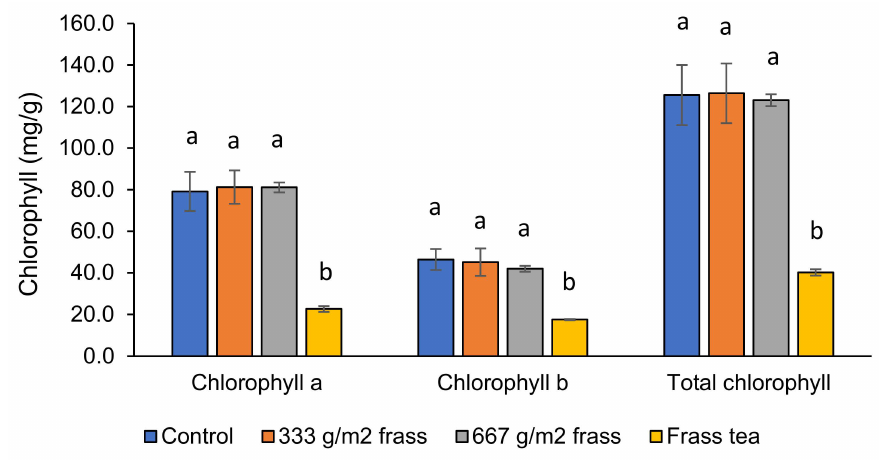
Figure 2. Mean ( ± SE) chlorophyll a, b and total chlorophyll (mg/g) content of sweetpotato slips three weeks of being grown with black soldier fly ( Hermetia illucens ) larvae frass products or inorganic fertilizer. Different letters above each bard indicate significant differences ( p <